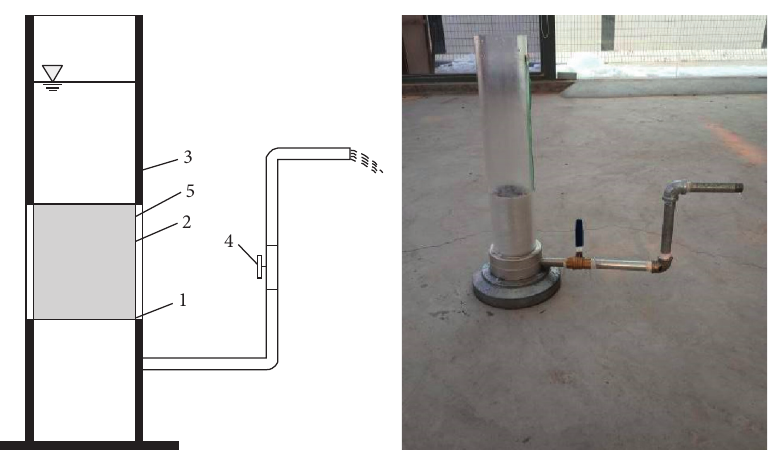
Figure 4: Test of permeability coefficient by using the variable water head